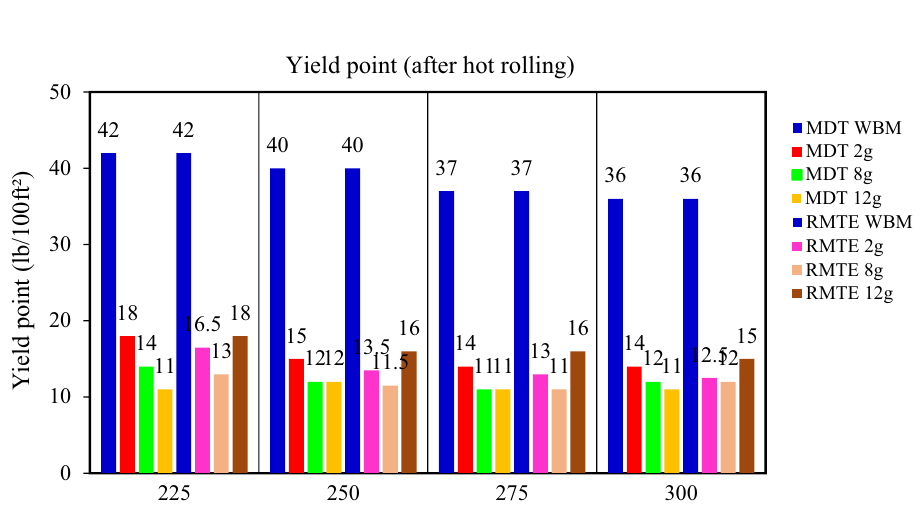
Fig. 12 Effect of temperature on yield point of MDT and RMTE mud